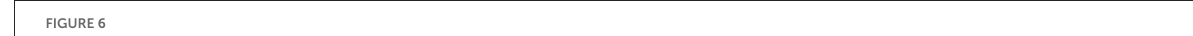
FIGURE6 photographs from the box-indicated regions in (A–E) show the details. (A–E) Quiescent microglia were evenly distributed with the processes interacting with CX3CL1 expressed on Nissl-labeled neurons in the normal group. Modeling was followed by the activation and accumulation of microglia around the increased neurons that expressed CX3CL1. (F,G) The three-dimensional images showed the increased contact of microglia and neurons after modeling. (H) The area ratio of CX3CL1 significantly increased at 1, 7, and 14 days after the operation. (I) Quantitation